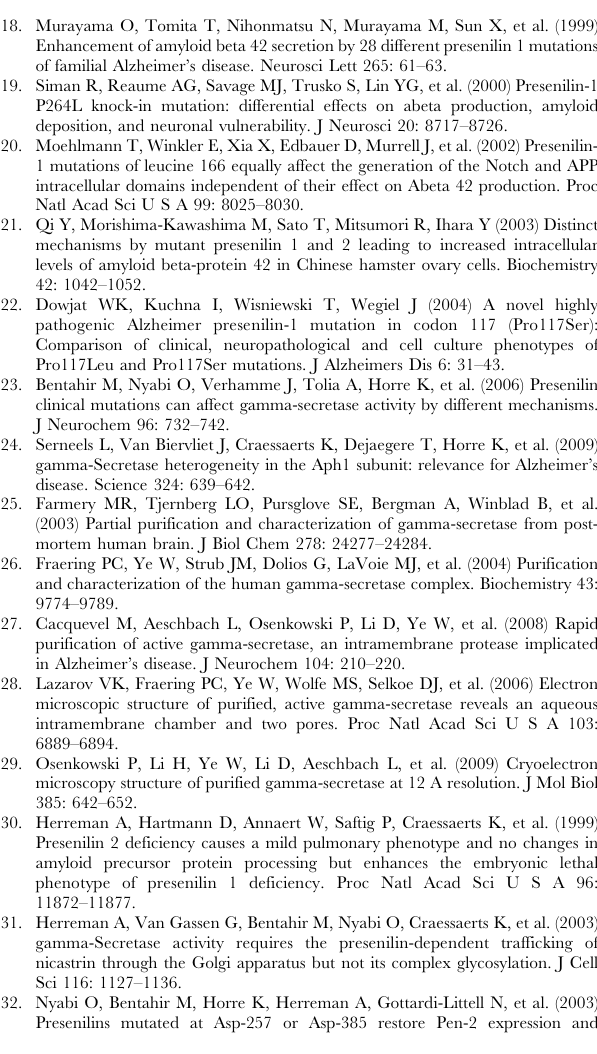
Table S1 Primers used to detect APH1 isoforms in MEF PS1/2 2 / 2 . F: Forward, R: